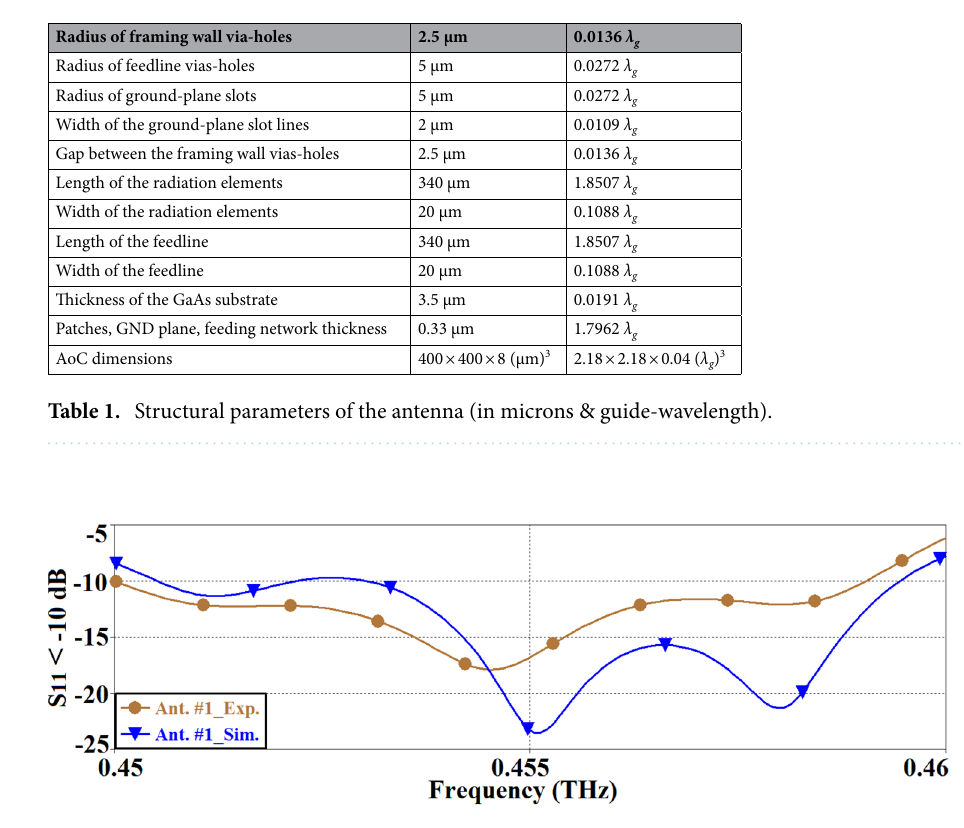
Figure 2. Simulated and measured reflection coefficient response of the SIW inspired antenna (Ant.